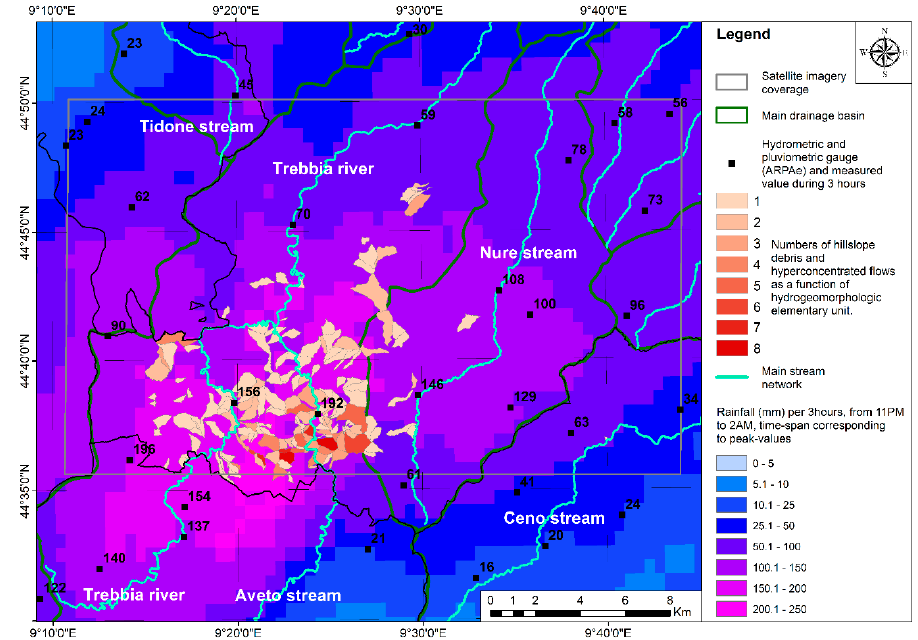
Figure 4. Distribution of hillslope debris and hyperconcentrated flows surveyed in the study area within hydrogeomorphologic elementary units and their classification.